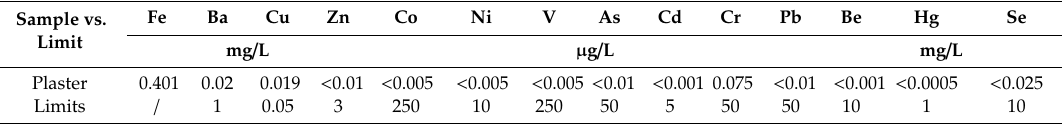
Table 12. Leaching test on eco-plaster. Last row: Standard limit concentration according to Lgs.D. 152 / 2006, Annex 5, title